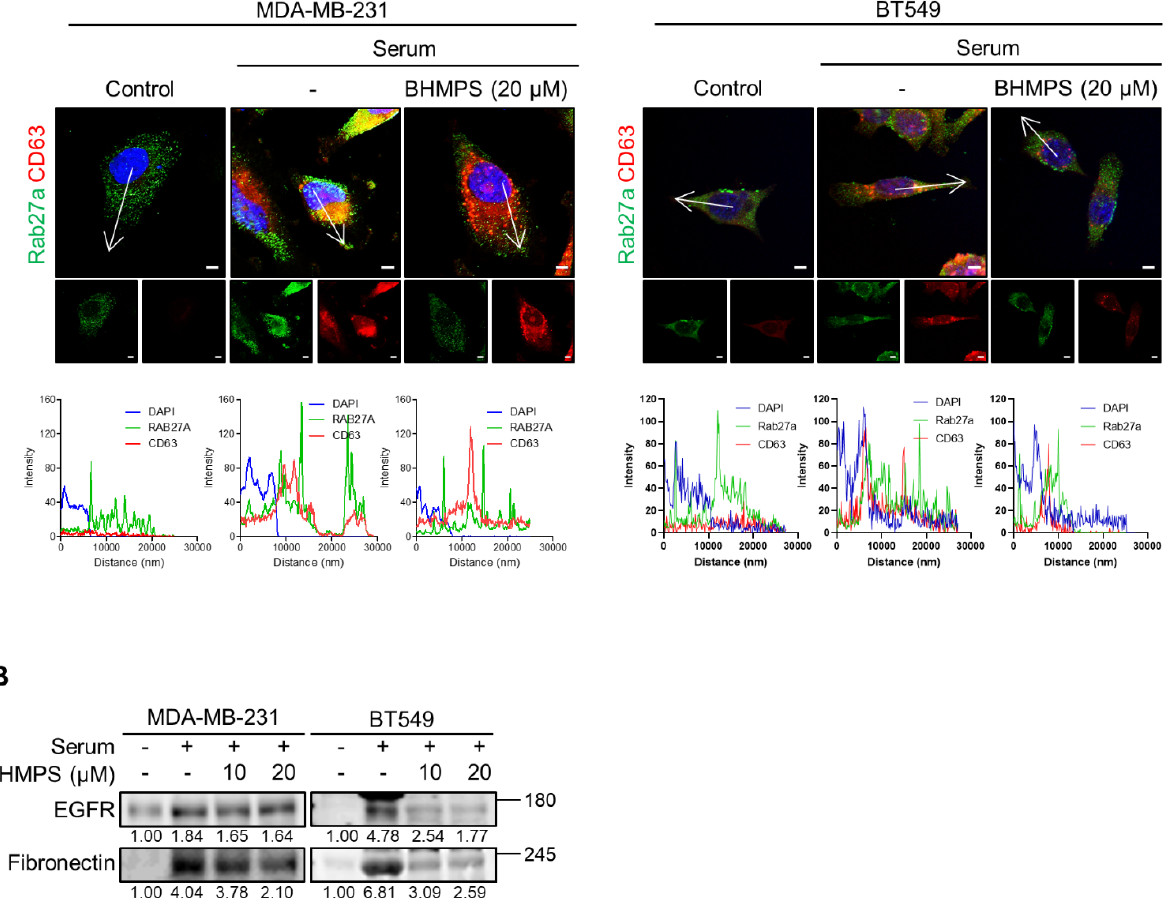
Figure 5. BHMPS interferes with the vesicle secretion process. ( A ) Confocal microscopic analysis was performed to examine the localization of exosome and Rab27a altered by BHMPS in MDA-MB-231 and BT549 cells. Exosome (Red) was labeled with the CD63 antibody and an Alexa 594-conjugated secondary antibody. Rab27a (Green) was labeled with the Rab27a antibody and an Alexa 488- conjugated secondary antibody. DAPI (300 ng/mL) was used to mark the nucleus (Blue). The scale bar represents 5 µm. The single channel images of Rab27a and CD63 are displayed below the left and right of the merged image, respectively. The fluorescence intensities at the marked white arrow were analyzed using Carl Zeiss ZEN lite software and represented in the bottom panel. ( B ) Overnight serum-starved cells were stimulated with 10% FBS and co-treated with the indicated concentrations of BHMPS for 24 h, and then conditioned media were collected. After quantification, levels of the specified proteins were analyzed using western blotting with the same concentration of proteins. The uncropped blots and the images of Ponceau S-stained membrane are shown in Supplementary Materials.